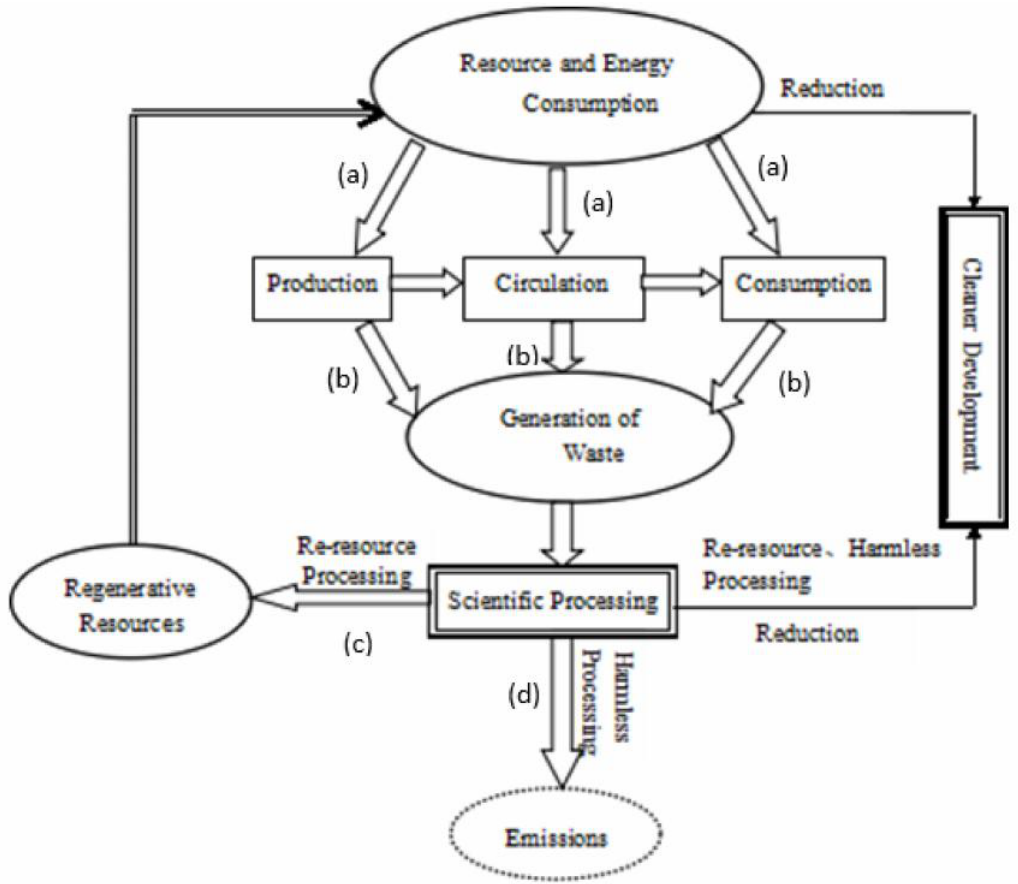
Fig. 1: Cleaner development pattern and its key